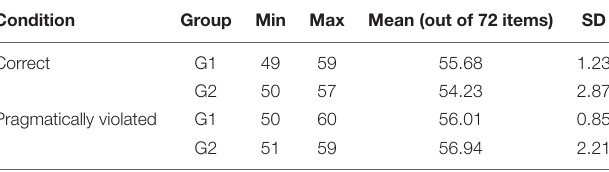
TABLE 3 | Descriptive statistics for the number of averaged epochs.